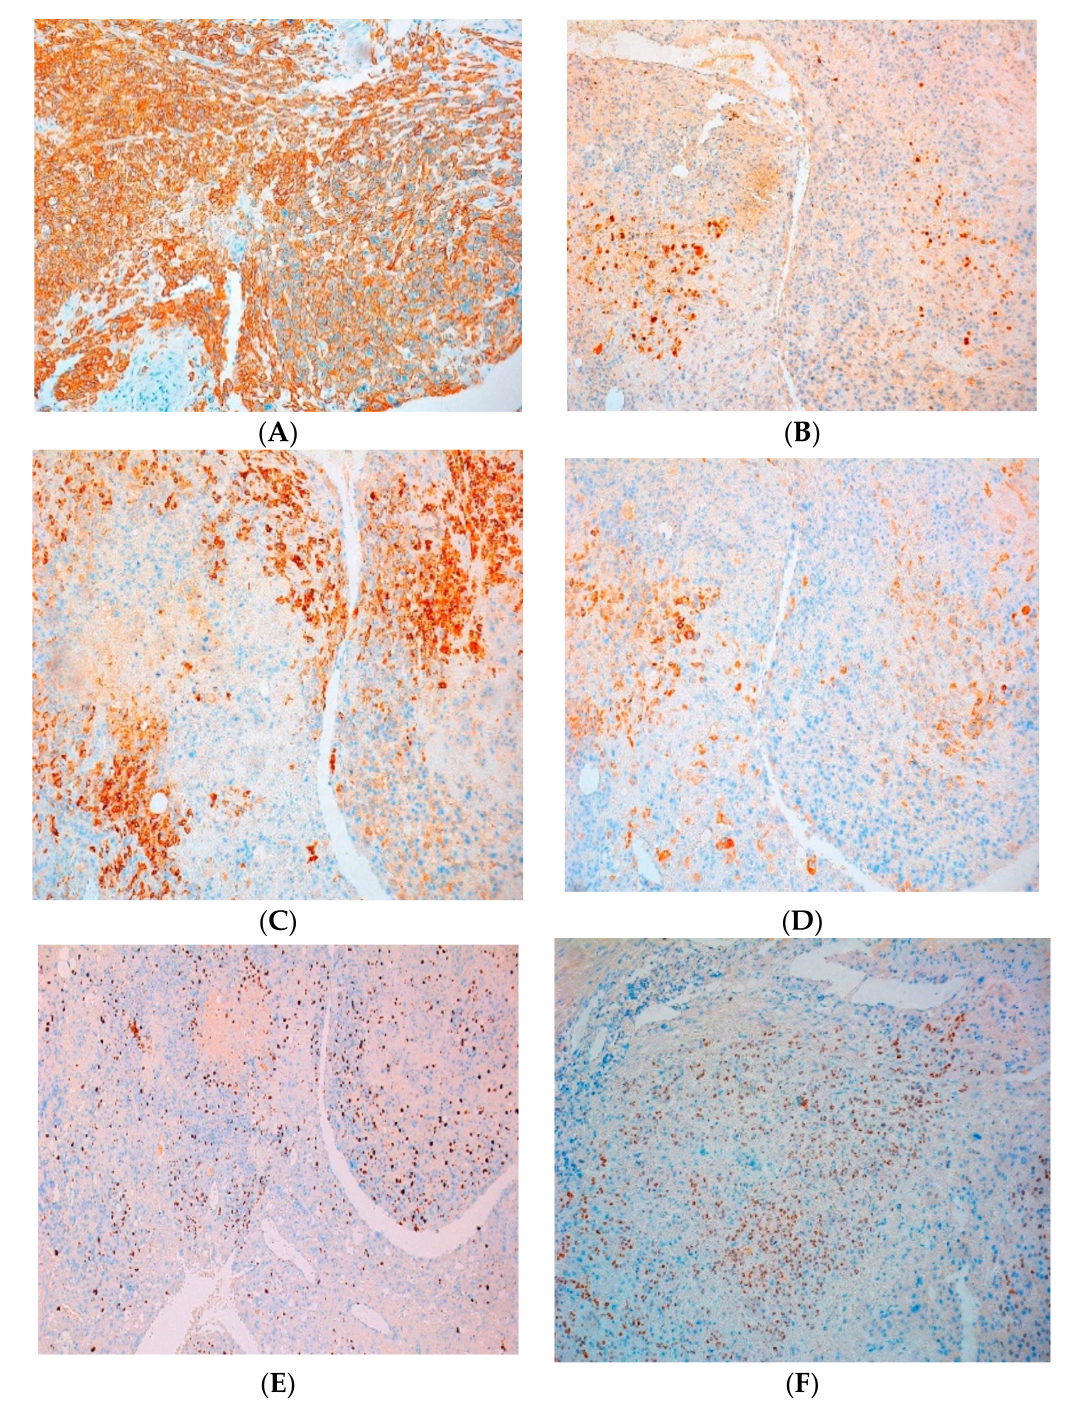
Figure 4. Immunohistochemistry assay: ( A ) CK-AE1/AE3 positive ( × 10) ( B ) focal positive cycline D1 ( × 10) ( C ) EMA positive ( × 10) ( D ) focal positive inhibin alpha ( × 10) ( E ) The Ki-67 index revealed 25% on proliferation activity ( × 5). ( F ) P 63-weakly positive, zonal extended in tumor cells ( ×